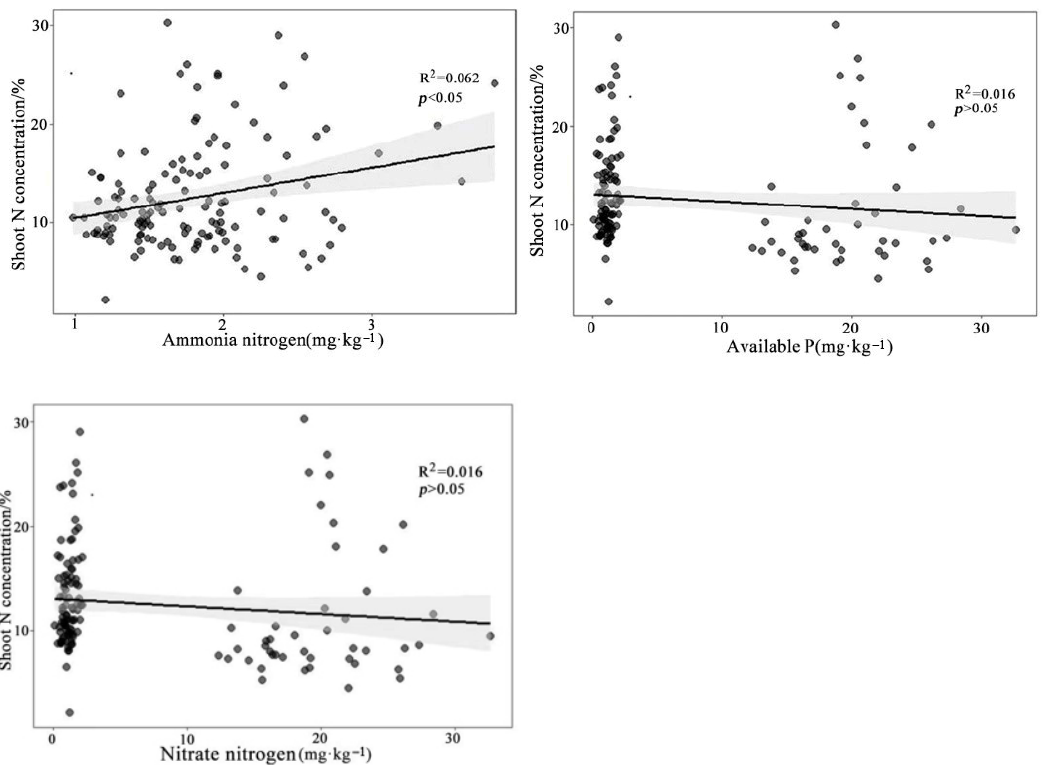
Figure 11. Relationships between available P, NH 4+ -N, and NO — -N contents in soil and plant N.